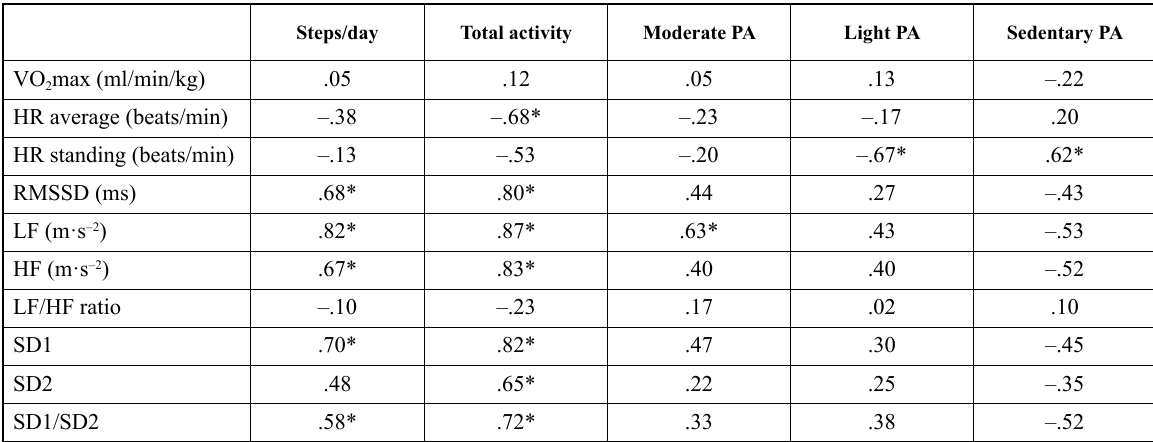
Table 3. Spearman’s correlations (rs) relationships between components of physical active, cardiorespiratory fitness and heart rate variability during standing position